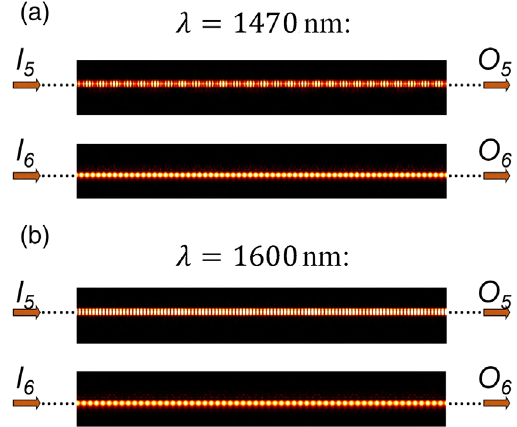
FIG. 13. The bandwidth of the optical waveguide structure. (a), (b) The simulated intensity patterns in the region near the output ports ( 940 – 980 μ m) with wavelength λ ¼ 1470 and 1600 nm. All geometric parameters are the same as those in Fig.